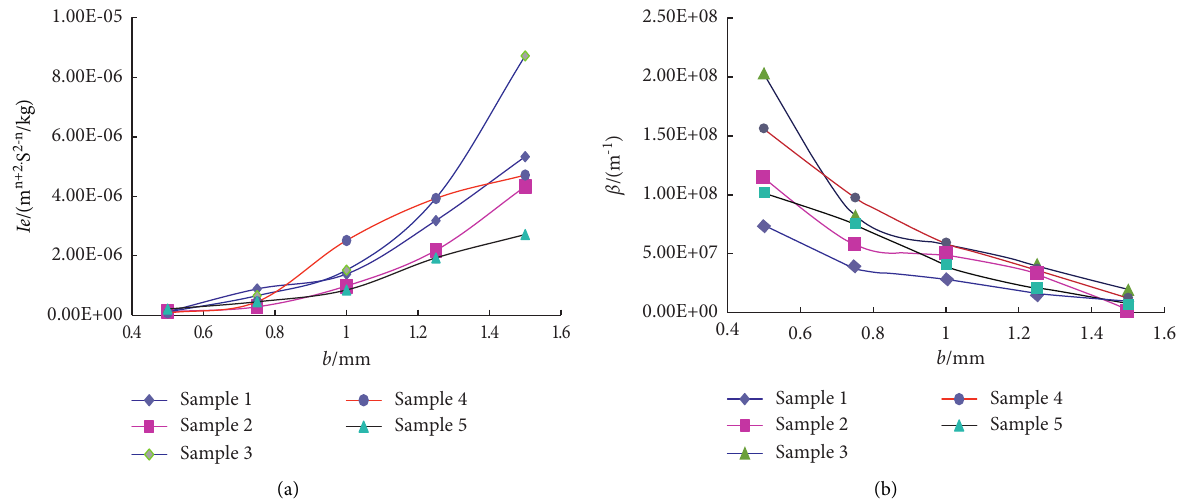
Figure 4: Curves of permeability parameters changing with the aperture at d